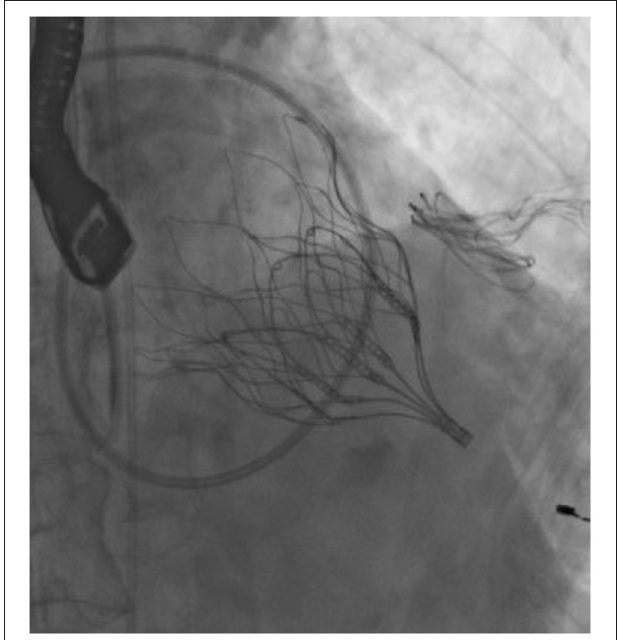
FIGURE 1 | Transesophageal echocardiography showing Tendyne TM valve (Abbott) after deployment. FIGURE 2 | Fluoroscopy showing Tendyne TM valve (Abbott) after